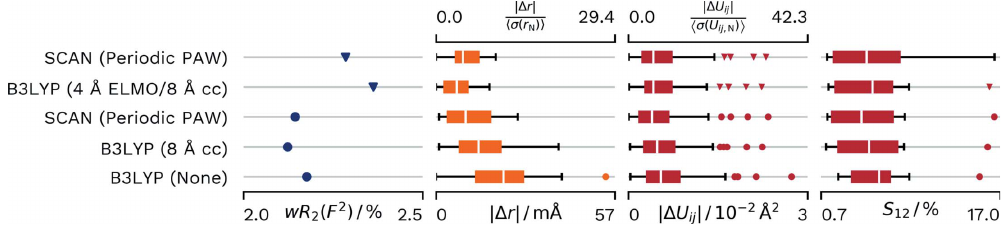
Figure 7 Differences in wR 2 ( F 2 ) and agreement with neutron values for different density sources for HAR of Xy . Refinements marked with triangles do not include an extinction correction, while refinements marked with circles do. Distributions of parameters are displayed as box-whisker plots. SCAN (Periodic PAW) was conducted with our script and GPAW . The B3LYP (4 A˚ ELMO/8 A˚ cc) values are from the reference calculation from the literature (Wieduwilt et al. , 2021) and used ELMOs as a tool for quantum-mechanically calculating a 4 A˚ cluster in addition to 8 A˚ of cluster charges for the crystal approximation. B3LYP (8 A˚ cc) uses 8 A˚ of cluster charges and was refined with NoSpherA2 / TONTO . B3LYP (None) was calculated with NoSpherA2 / ORCA without any approximation of the crystal environment.